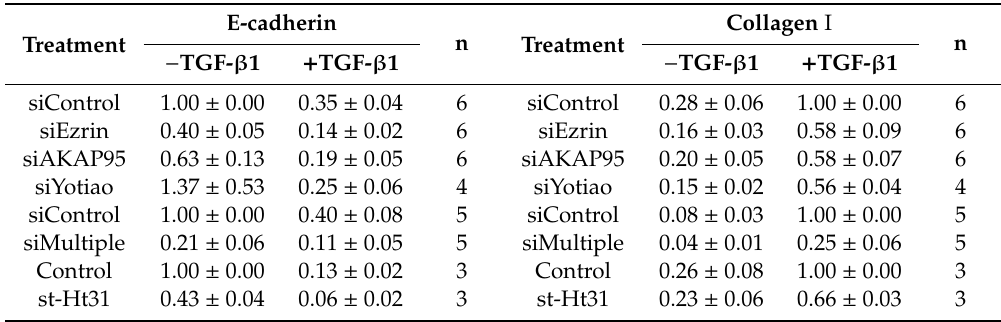
Table 3. The comparison of E-cadherin and Collagen Ӏ protein expression in signal and multiple AKAPs silencing and the pretreatment of